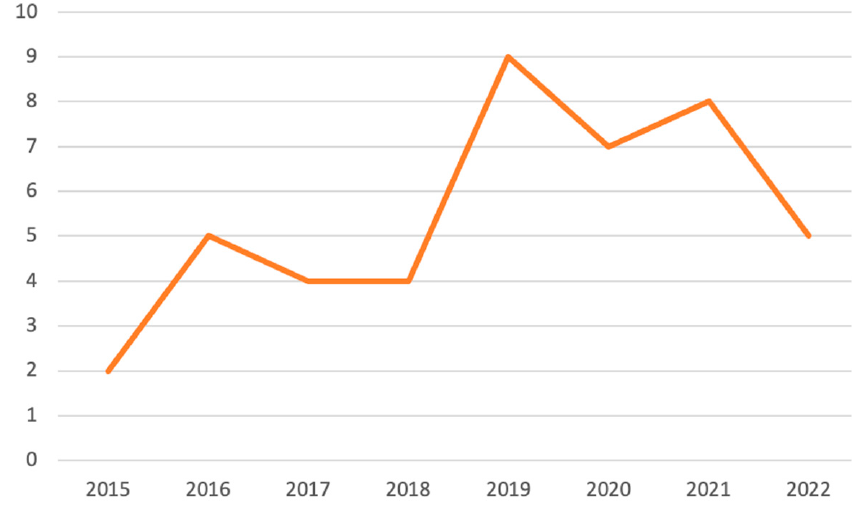
Figure 2. Distribution of articles discussed.